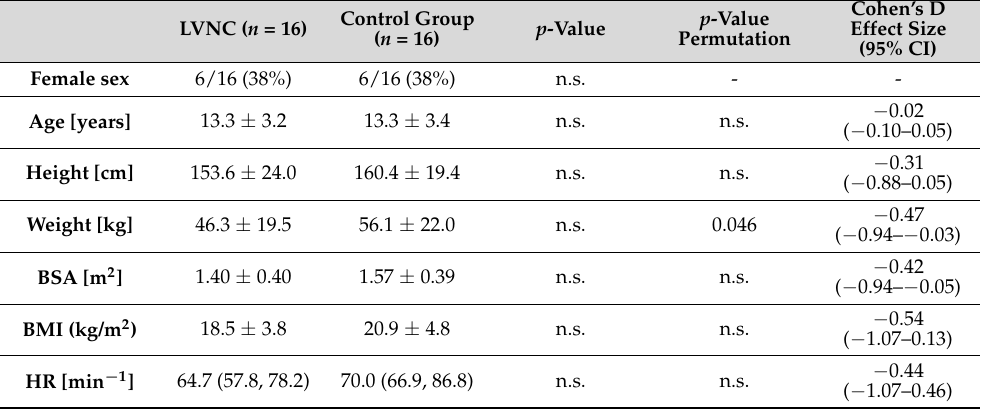
Table 1. Patient characteristics. BSA indicates body surface area; BMI, body mass index; HR, heart